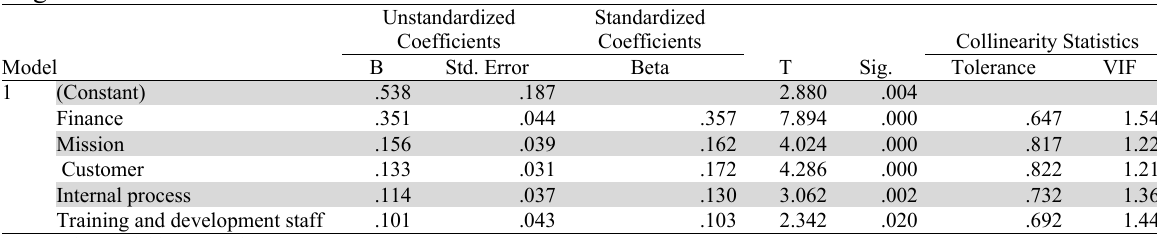
Regression results in the research model